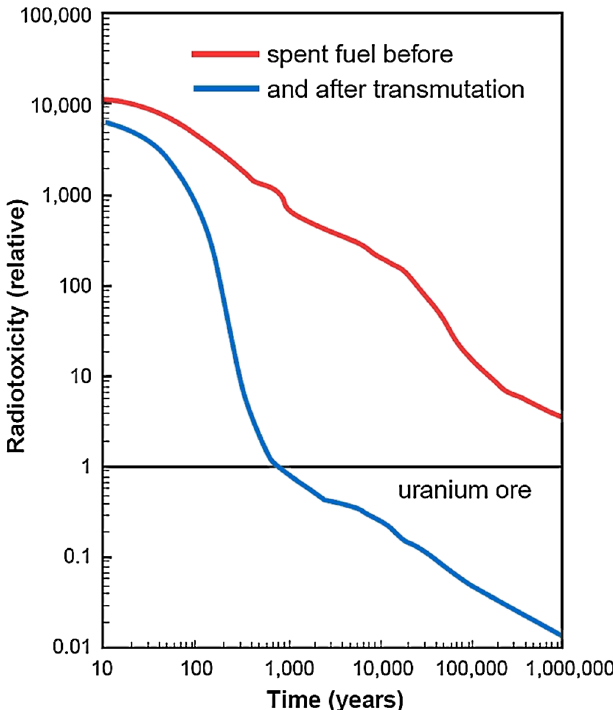
FIG. 1. (Color) Comparison of the decay time of the radiotox- icity of nuclear waste to the reference level of the original uranium ore before and after transmutation